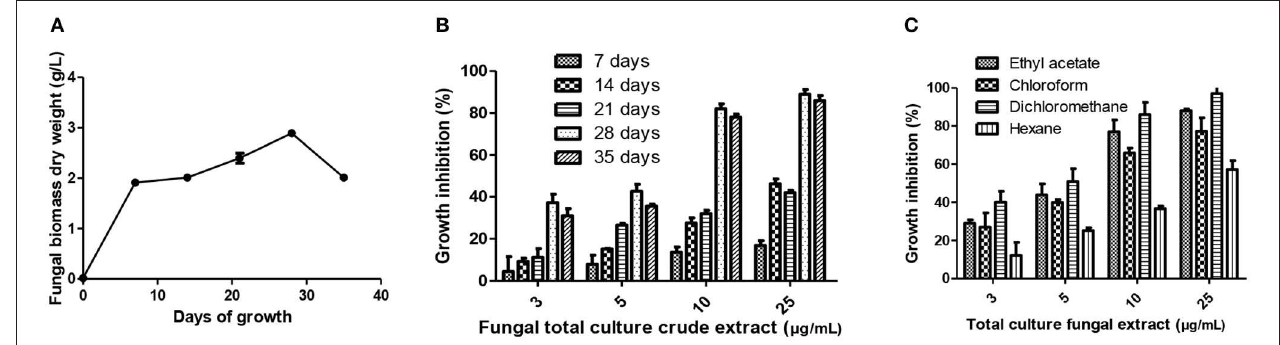
FIGURE 6 | Culture condition optimization of crude extract of A. unguis (AG 1.2). (A) Growth curve analyses of A. unguis grown in PDB. (B) Optimization of incubation time interval for production of cytotoxic secondary metabolites evaluated by MTT assay on A431 cells. (C) Evaluation of appropriate organic solvent for total extraction